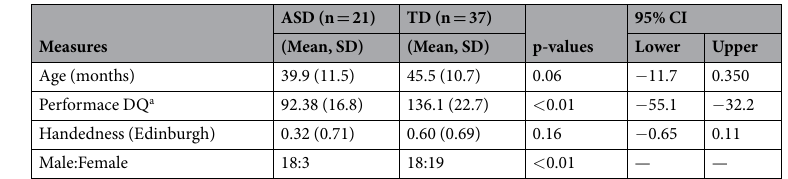
Table 1. Demographic and clinical characteristics of the ASD and TD children (n = 58). ASD = Autism Spectrum Disorders; TD = Typically Developing children; CI = Confidence Interval of the Difference. a Griffiths Mental Development Scales: Mean = 100, SD = 15.